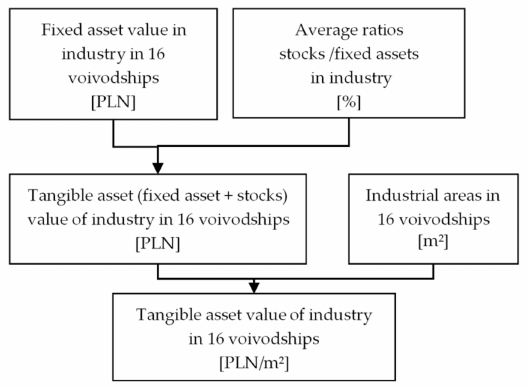
Figure 4. Approach to estimating asset values in industrial areas for 16